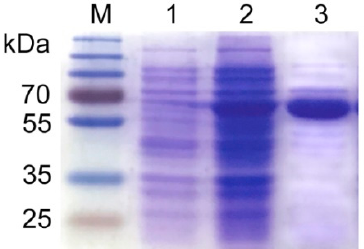
Figure 1. Characterization of Nb28-AP by SDS-PAGE. Lane M: Prestained protein ladder. Lane 1: Whole-cell protein before auto-induction. Lane 2: Whole-cell protein after auto-induction. Lane 3: Nickel sepharose column-purified Nb28-AP.